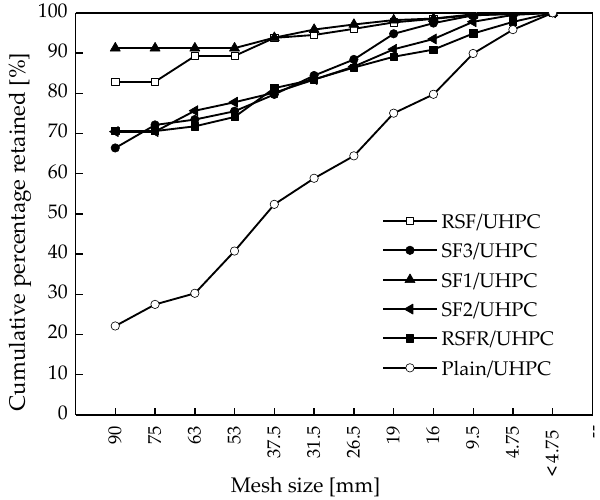
Figure 13. Particle size distribution of all types of specimens exposed to a temperature of 800 °C.